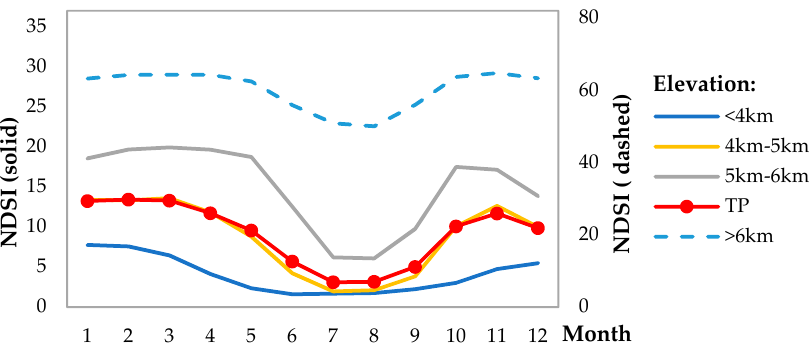
Figure 13. Annual cycle of average NDSI at different elevation zones over the TP during 2001–2017.